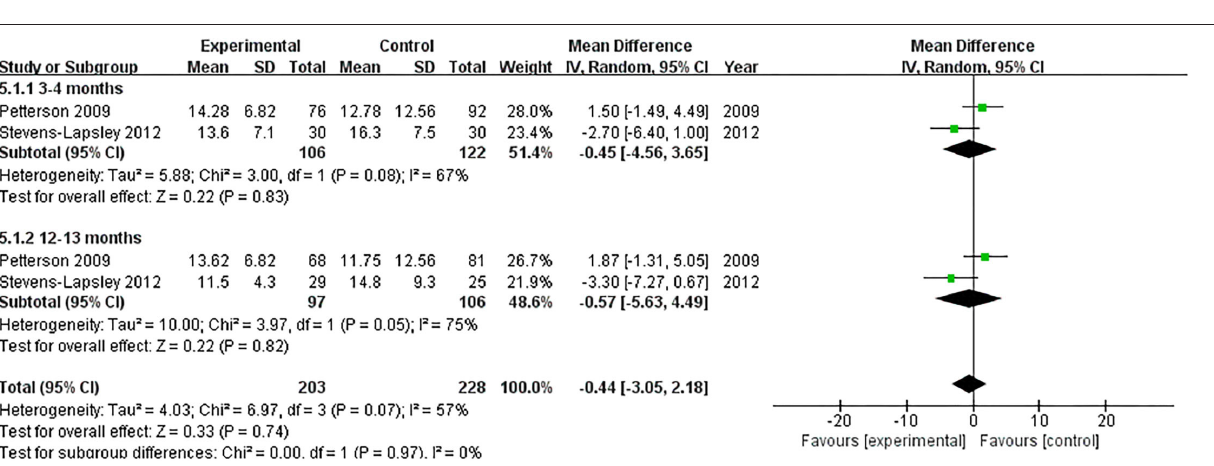
Frontiers in Medicine |